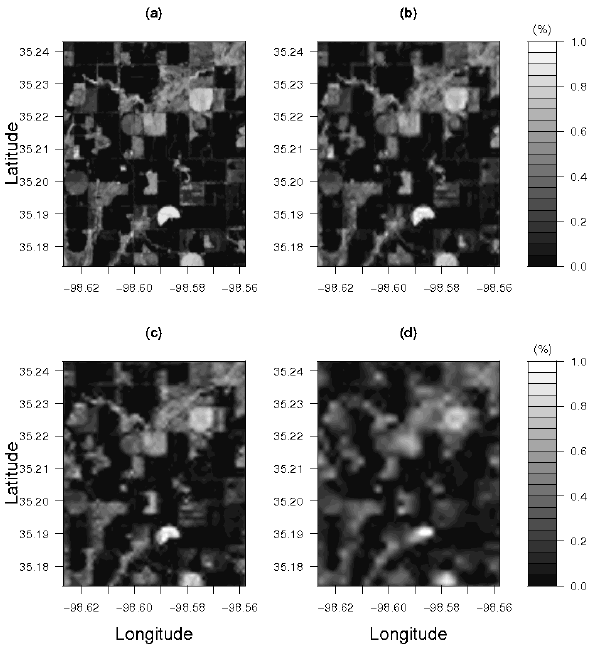
Fig. 1. (a) Original Landsat fractional vegetation (Fr, [%]) field (100m) and low pass filtered versions at select spatial resolutions (b) 200m, (c) 1600m and (d) 12800m.